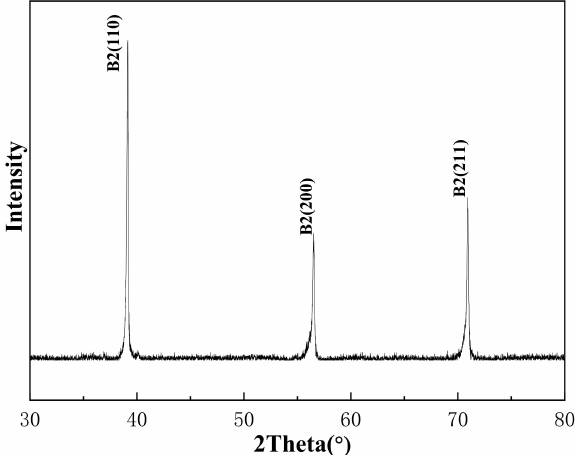
Figure 9. XRD patterns of weld